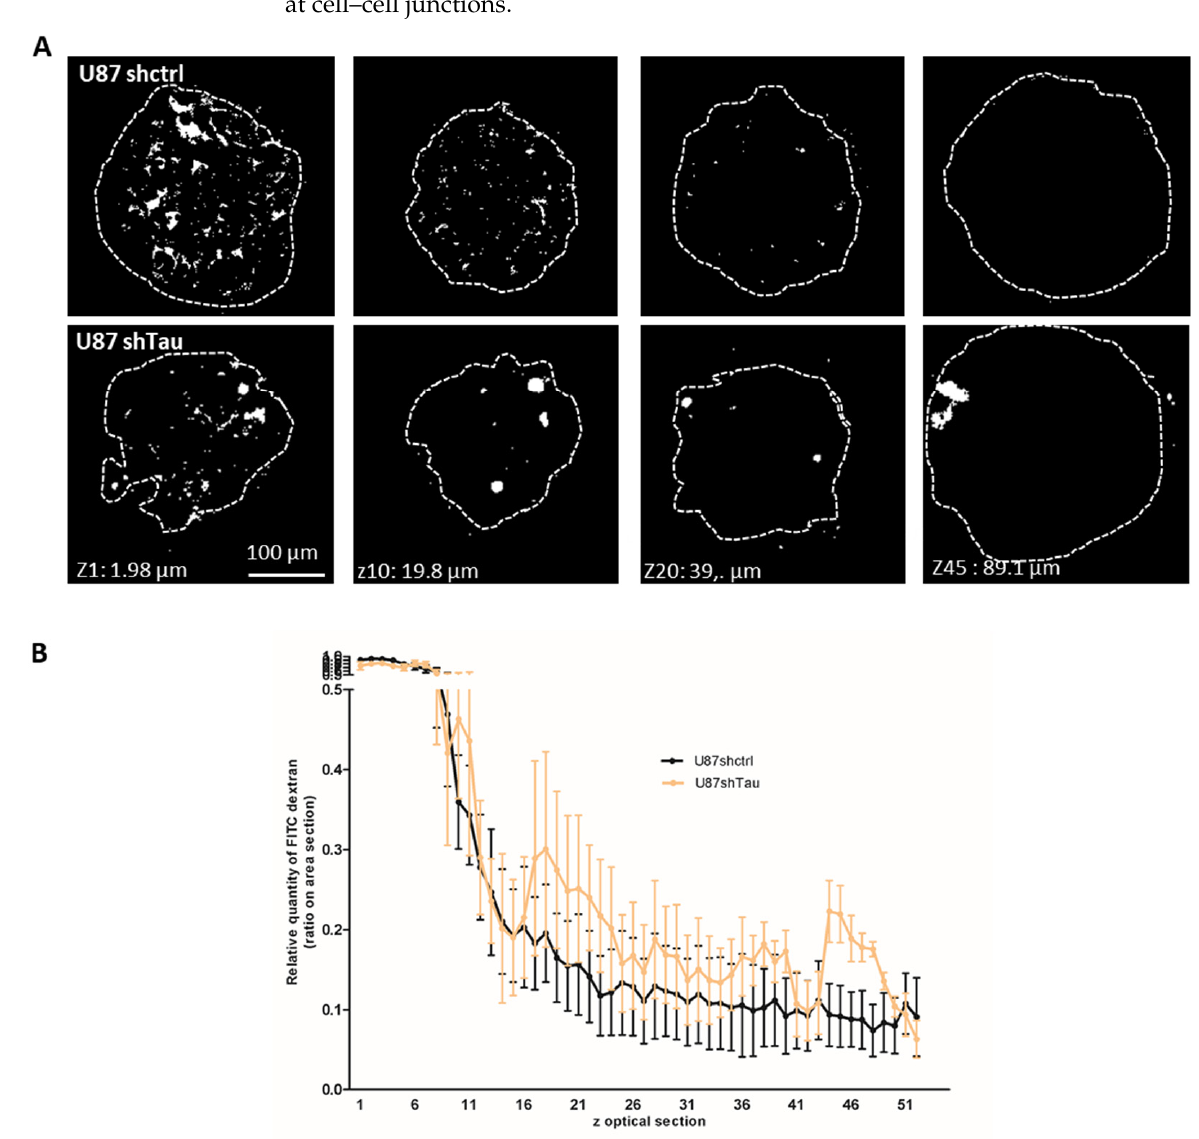
Figure 3. Tau down-regulation affects spheroid paracellular permeability. ( A ) Spheroids were incubated with FITC-Dextran for 1 h and settled on fibronectin matrix for 30 min before confocal microscopy analysis. Representative images of z optical sections ( z = 1.98 µ m) after image thresholding are shown (obj 20 × ). ( B ) Quantification of FITC-Dextran infiltration in spheroids. The graph shows the area of FITC staining through spheroid optical sections. The relative quantity of FITC-Dextran accumulation is expressed as the ratio of the area of FITC-labeled objects on the total area of spheroid optical sections, expressed as a percent of sections having the highest FITC accumulation normalized to 1 ( N = 6 for each group MCS, p < 0.001).